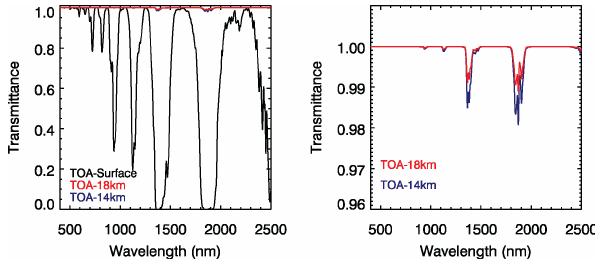
Figure 2. (left) Water vapor transmittance (modeled at SSFR sam- pling and resolution) in a tropical atmosphere is shown from the surface (black), 14km (blue) and 18km (red) to the top of the at- mosphere. (right) An expanded plot of the water vapor absorption high in the atmosphere at 1400 and 1900nm.